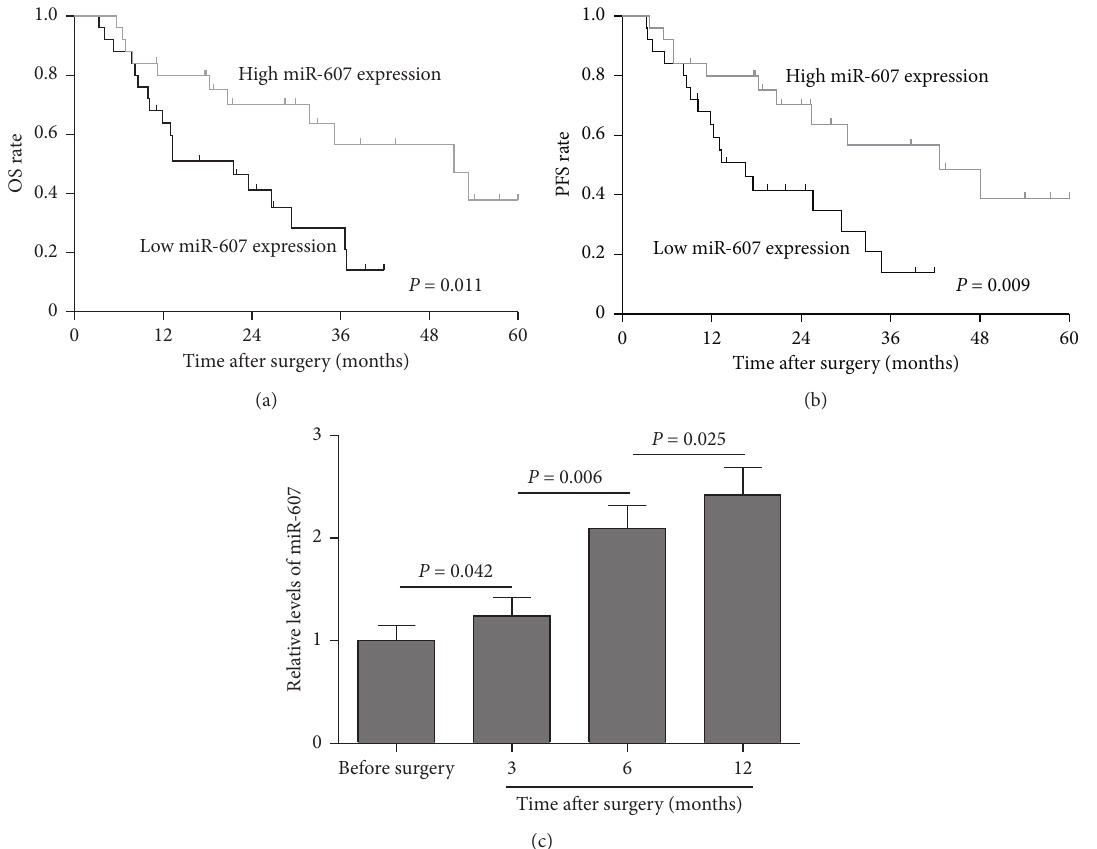
Figure 3: Kaplan–Meier survival curves for patients with PDAC based on miR-607 expression status. (a) Low miR-607 expression group had a significantly shorter OS than high miR-607 expression group. (b) The PFS was significantly worse in PDAC patients with low miR-607 expression than in those patients with high miR-607 expression. (c) qRT-PCR analysis of miR-607 expression levels in PDAC patients before and after surgery. OS: overall survival, PFS: progression-free